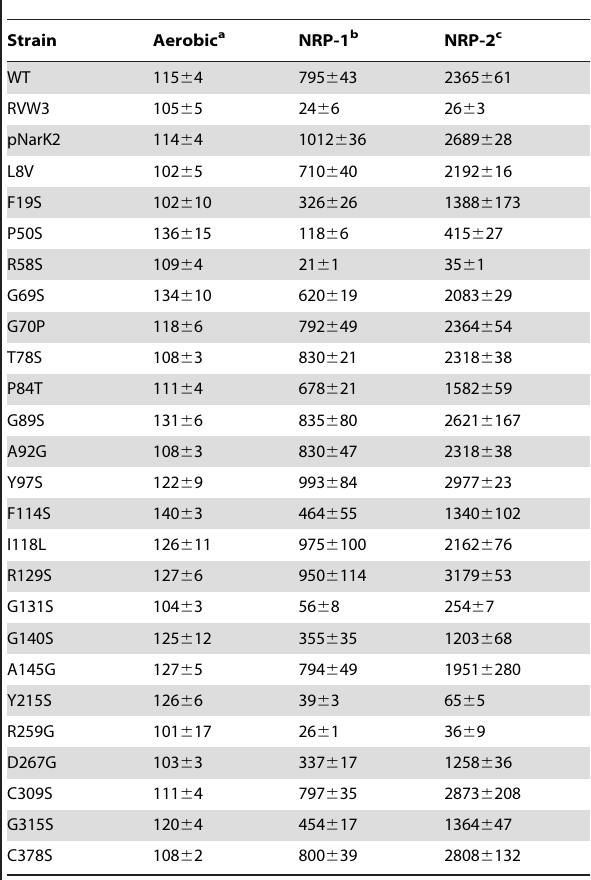
Table 2. Nitrate reductase activity of narK2